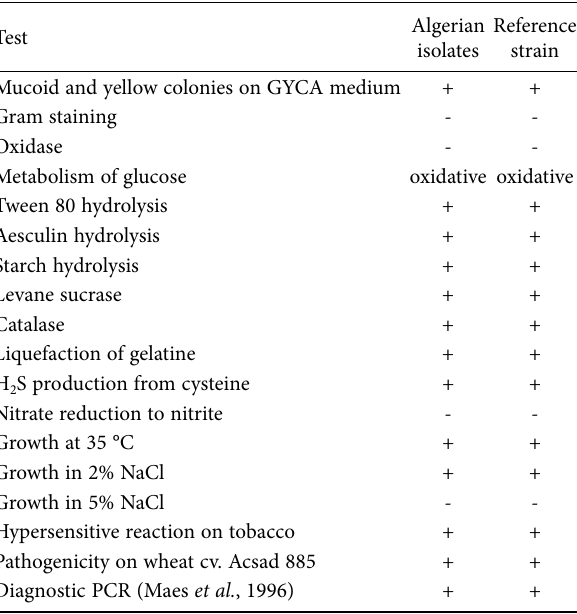
Table 2. Biochemical and physiological tests used to identify bacte- rial isolates from wheat, and a reference strain ( Xanthomonas trans- lucens pv. undulosa strain UPB753 (Bragard et al. ,